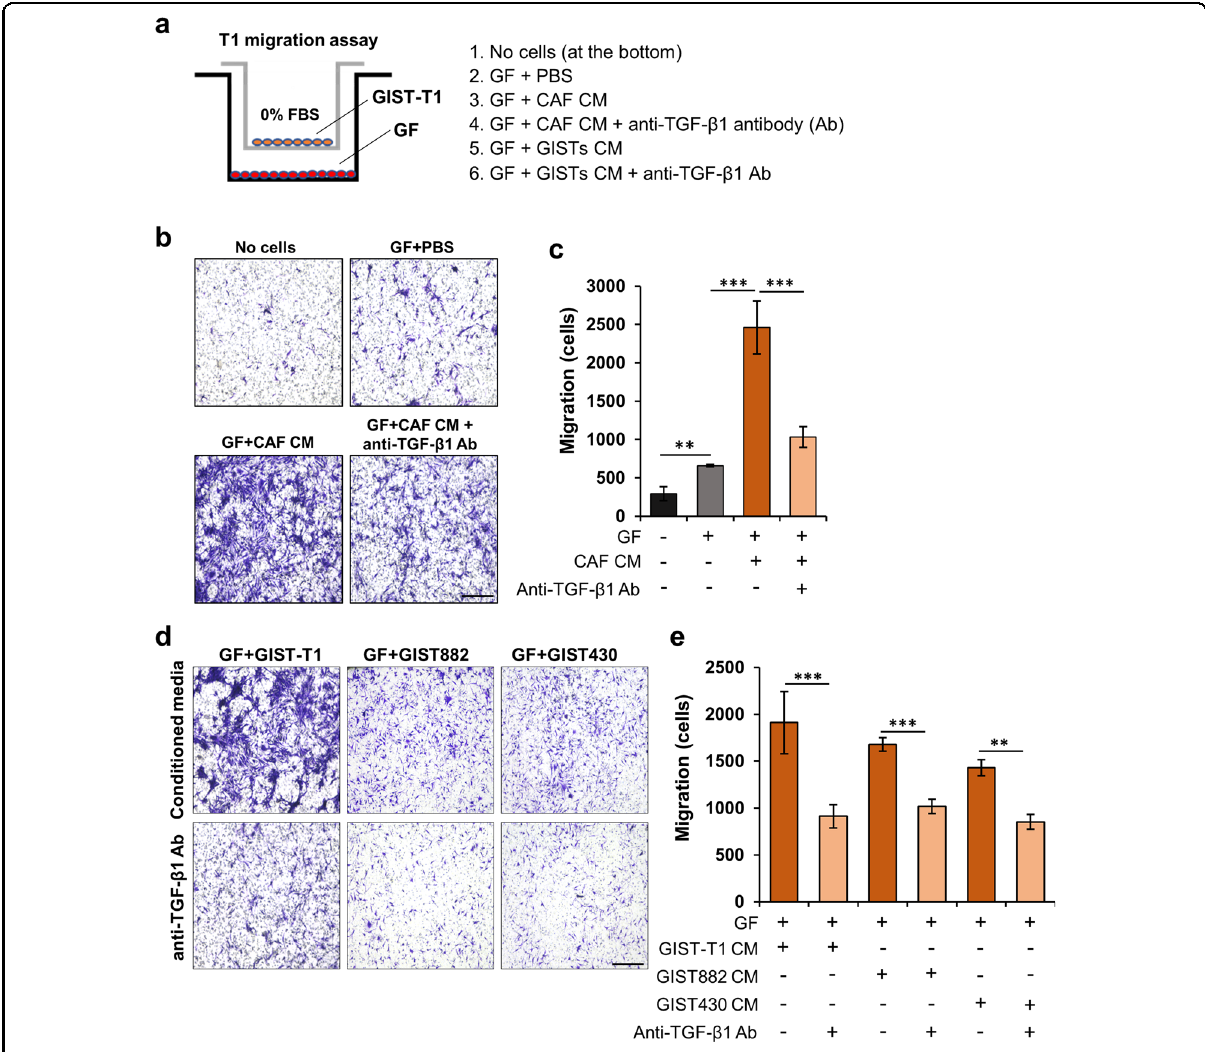
Fig. 5 TGF- β 1 secreted from GIST-T1 cells and CAFs is involved in increased GIST migration. a Experimental design of the Transwell migration assay. b , c Representative images ( b ) and quantitative data ( c ). GFs were treated with PBS (control), CAF CM, and/or TGF- β 1 blocking antibody (1 µg/ mL) for 24 h in the bottom well. The migrated GIST-T1 cells were imaged using a BZ-X800 Life Science Microscope and analyzed by ImageJ software. d Representative images showing Transwell migration assay of TGF- β 1 blocking antibody in GFs treated with CM of GIST-T1, GIST882, and GIST430. e Quantitative data of the migrated GIST-T1 cells in the indicated conditions. Scale bars, 200 µm. Graphs show mean ± SEM, and p values were represented by ANOVA analysis. ** p < 0.01, *** p <